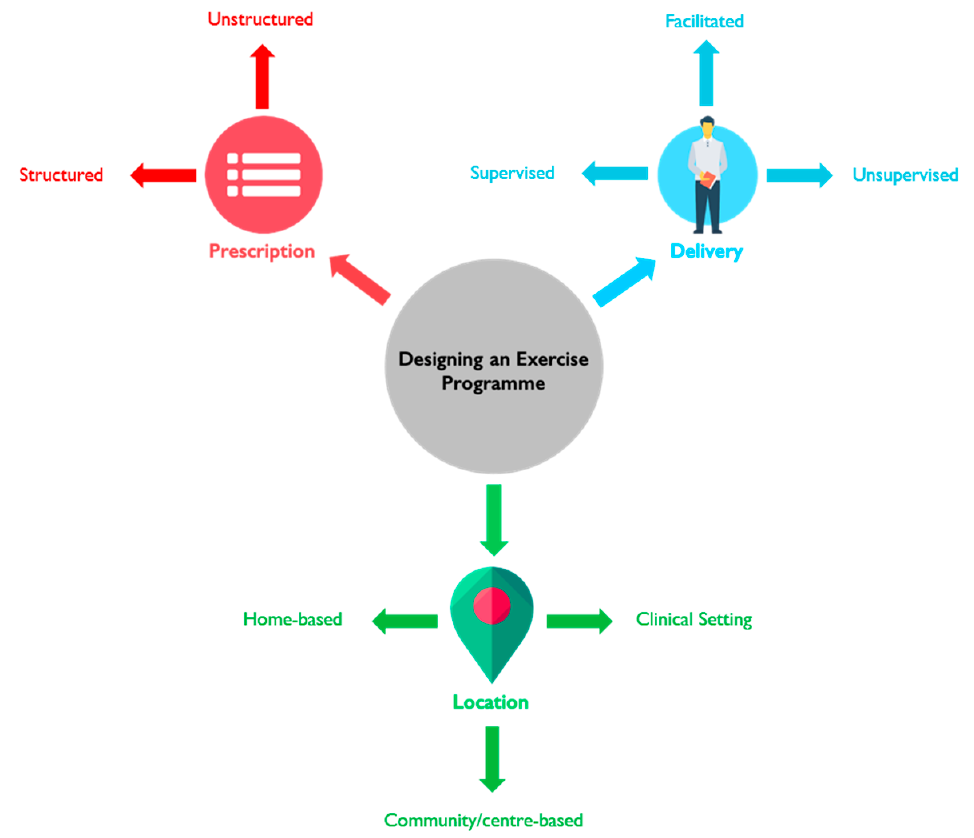
Figure 1. Domains and subdomains that require accurate definitions when reporting an exercise programme that are commonly utilised within existing reporting guidelines